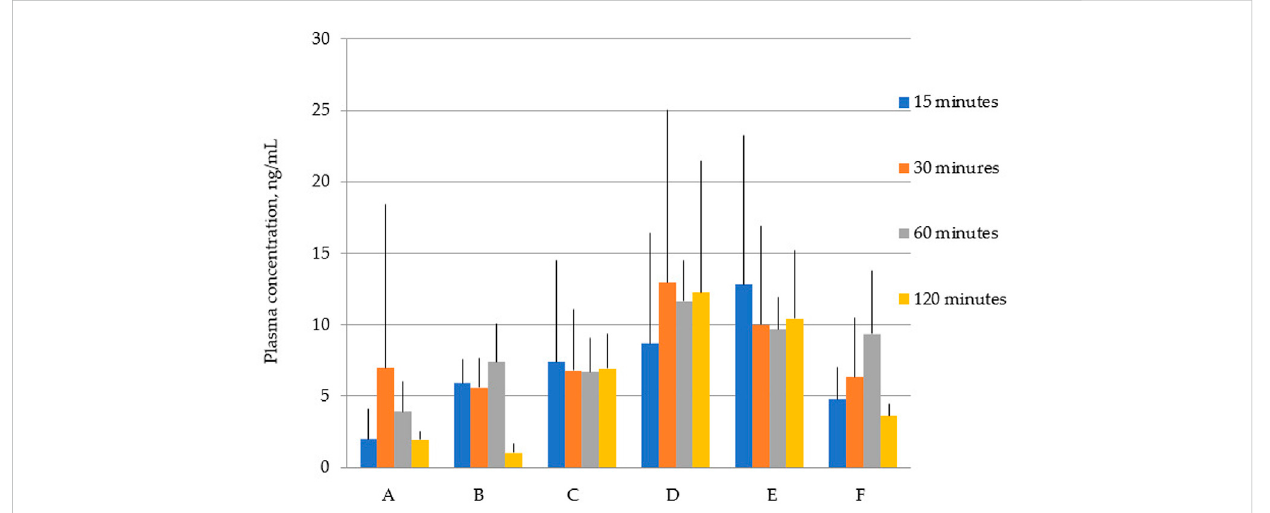
FIGURE 2 Concentration of latrepirdine for polymorphs (A – F) in blood serum samples. Data are presented as mean values for each polymorph at a speci fi c time point + standard